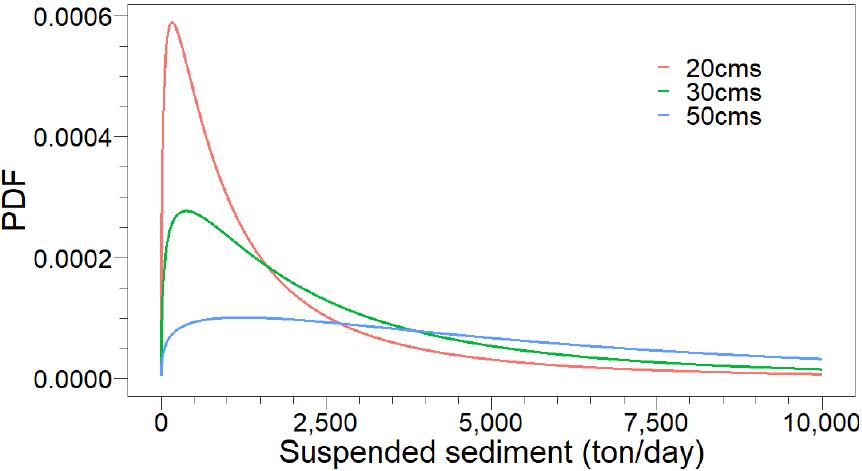
Figure 3. The CPDFs of suspended sediment load given observed discharge equals 20, 30, and 50 m 3 /s, respectively.